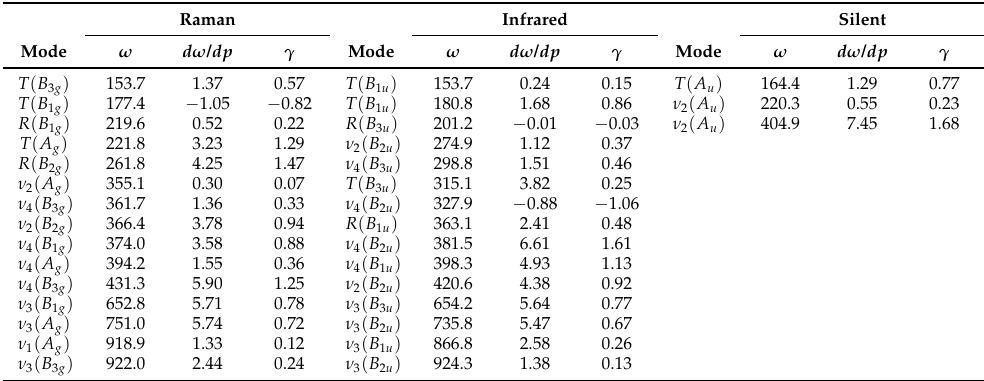
Table 3. Calculated Raman, infrared, and silent phonon frequencies ( ω in cm − 1 ), pressure coefficients ( d ω / dp ), and Grüneisen parameters ( γ ) of FeVO 4 - II .